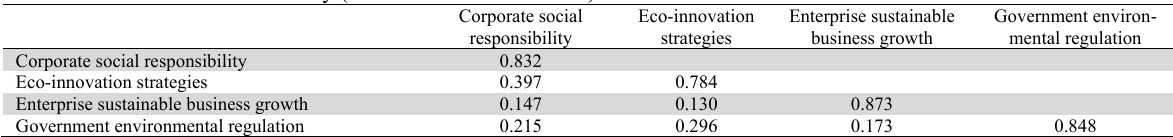
The results of discriminant validity (Fornell-Larcker Criterion)